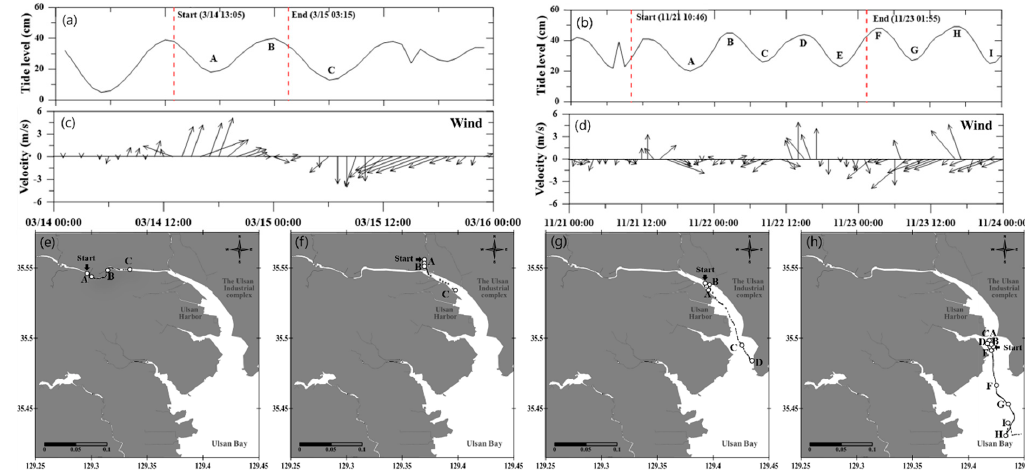
Figure 2. Lagrangian trajectories of the floating buoys with tidal elevation and wind vectors in the Taehwa River estuary in Korea in March and November 2012. ( a , b : tide level during the survey; c , d : wind velocity during the survey; e , f : buoy trajectories in march 2012; g , h : buoy trajectories in November 2012; Tide level data were acquired from the Korean Hydrographic and Oceanographic Agency (www.khoa.go.kr); Wind velocity data were acquired from the Korea Meteorological Administration (www.kma.go.kr)).